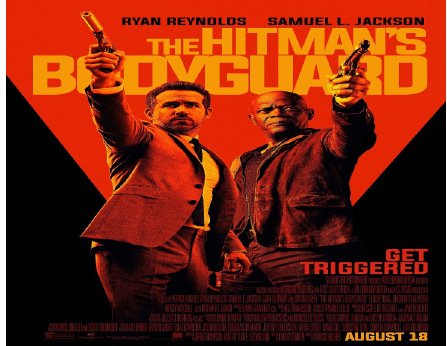
Fig. 9. The Hitman’s Bodyguard (2017)